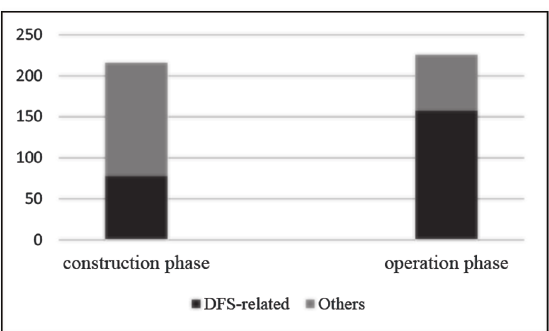
Figure 6. Statistics of incidents by phases